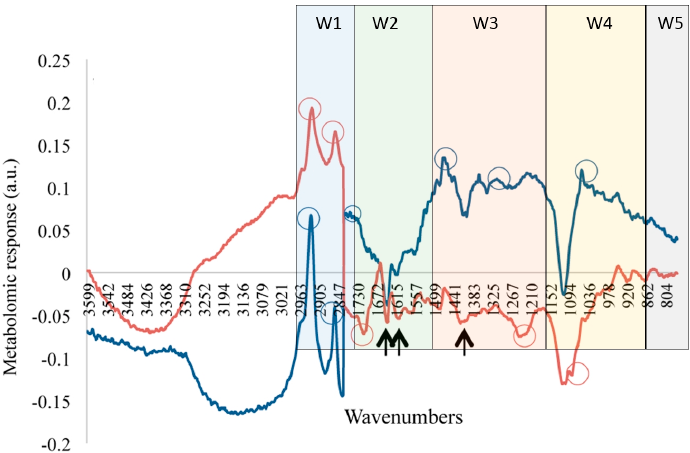
Figure 6. Comparison between the FTIR Response Spectra of E. coli and L. innocua at the surfactants concentrations of N -tetradecyltropinium bromide that resulted in 100% mortality. Note: a.u. stands for “arbitrary units”. Arrows correspond to the wavenumbers referred to peptidoglycan while circles to the wavenumbers referred to the major response peaks in each species. Blue, L. innocua ; Red, E. coli . The synthetic stress of the metabolomic stress response are defined by the following FTIR regions: fatty acids (W1) from 3000 to 2800 cm − 1 , amides (W2) from 1800 to 1500 cm − 1 , mixed region (W3) from 1500 to 1200 cm − 1 , carbohydrates (W4) from 1200 to 900 cm − 1 and typing region (W5) from 900 to 700 cm − 1 . Adapted from Corte et al. [125].